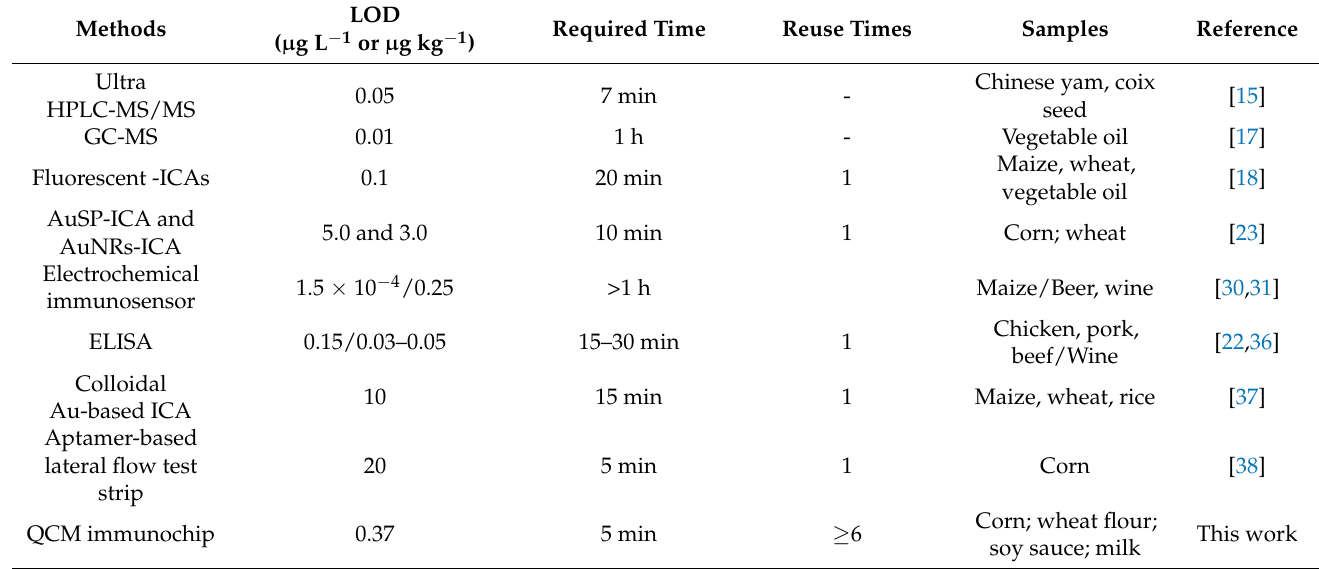
Table 2. Results of the comparison of different reported methods for ZEN